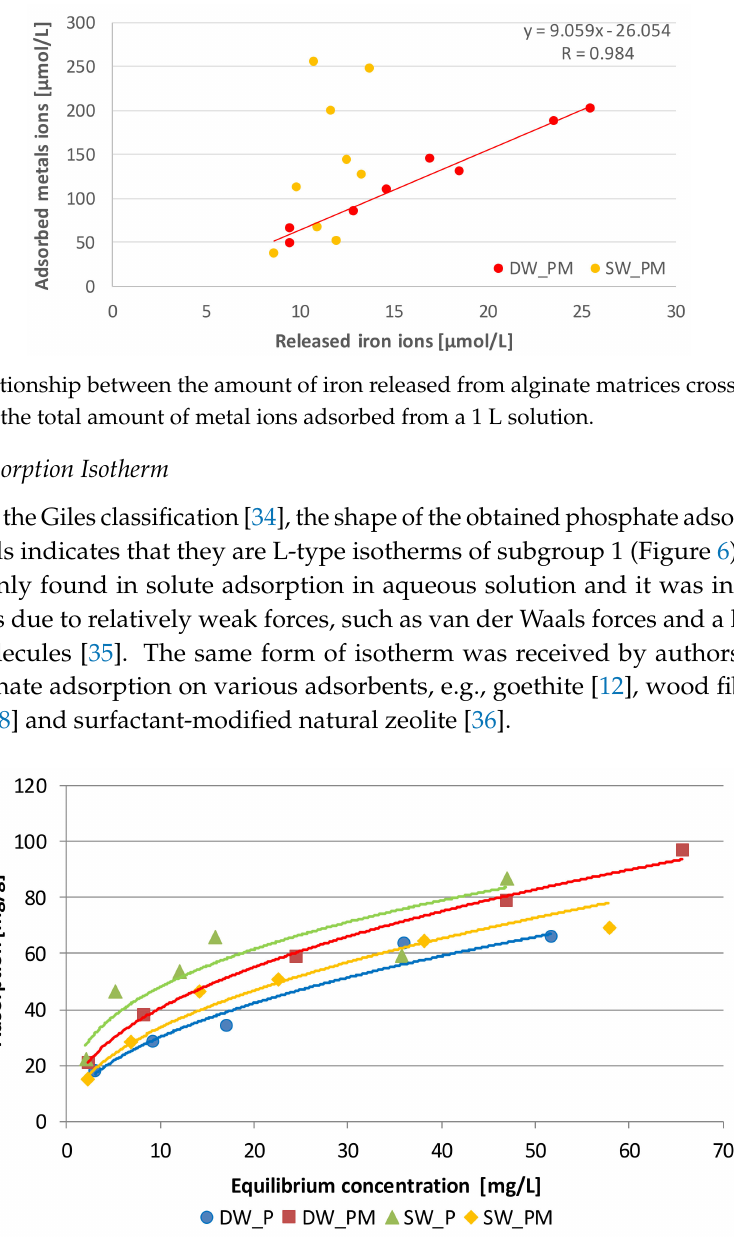
Figure 6. Freundlich isotherms of phosphate adsorption onto alginate matrices cross-linked with Fe 3 + ions. DW_P—deionized water enriched with phosphate, SW_P—e ffl uent from a sludge enriched